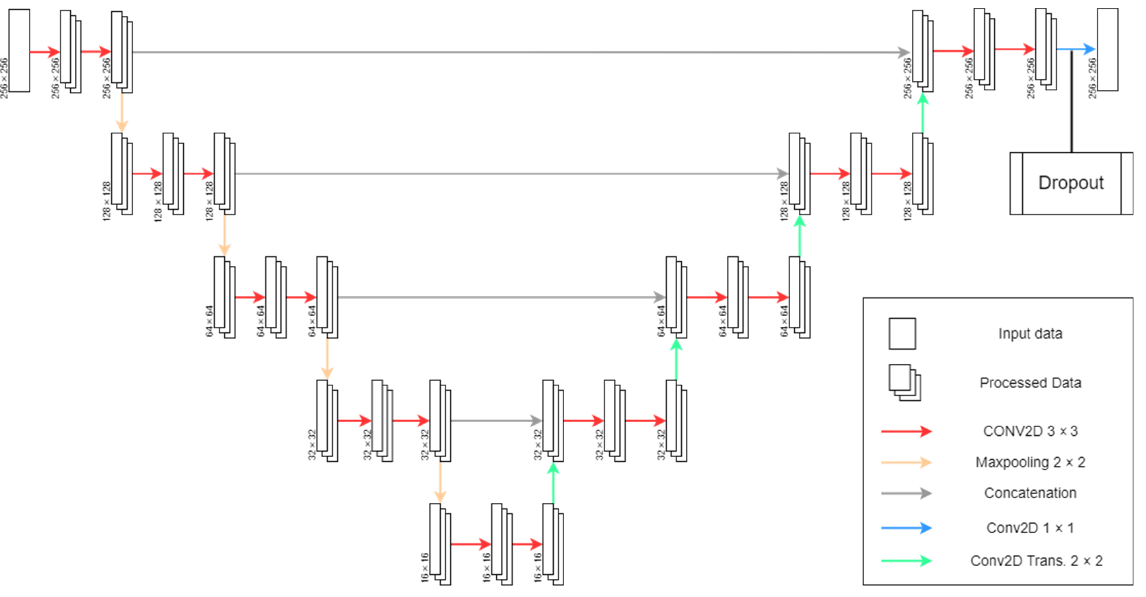
Figure 5. The modified U-Net model for road detection and mapping applied to 10 m pixel-size Sentinel-2 imagery based on Refs. [21,30]. Sentinel-2 imagery based on Refs.